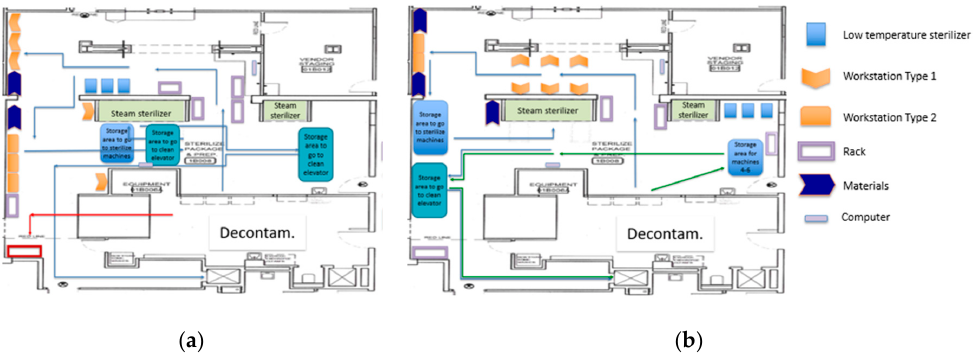
Figure 15. SPD layout: ( a ) Before the Enhanced KE, ( b ) After the Enhanced KE.